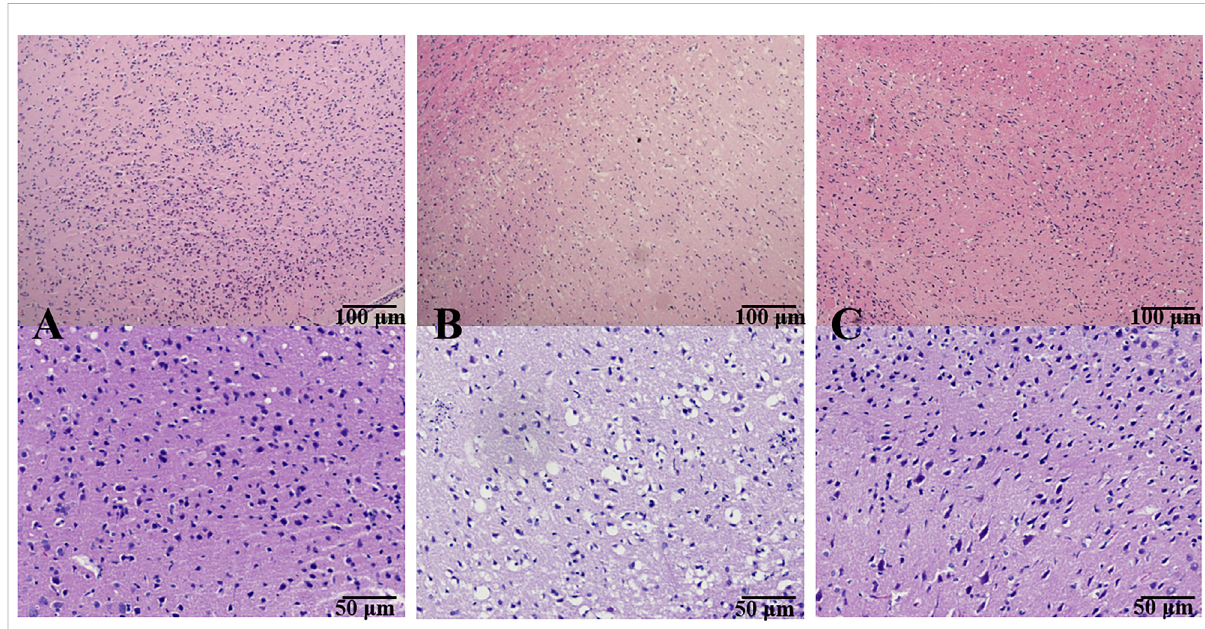
FIGURE 3 EffectofBMDonhistopathologicalabnormalityofbraintissue.Originalmagni fi cation:×4and×10. (A) SHAMgroup; (B) MCAO/Rgroup;and (C) BMDM